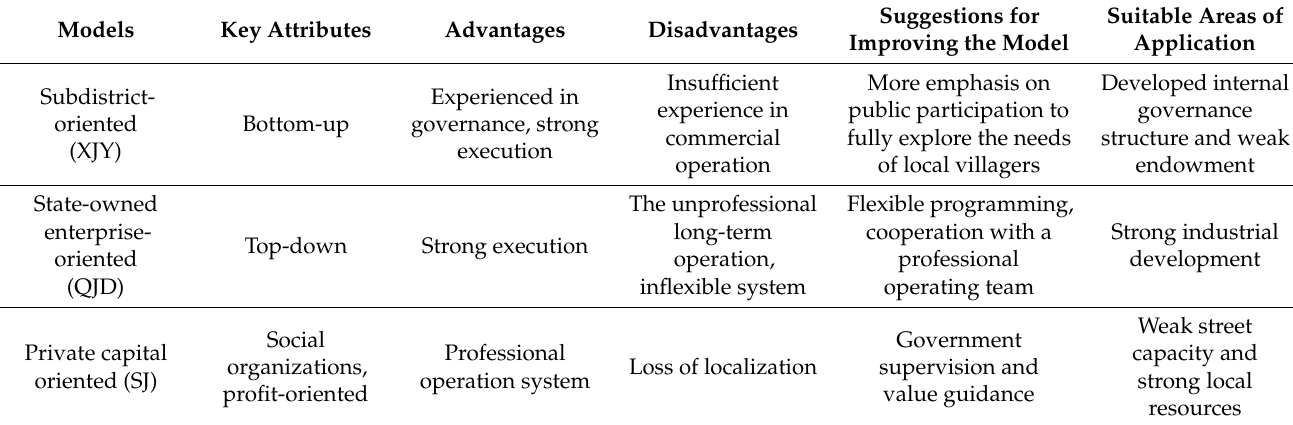
Table 3. Comparison of stakeholder-led approaches of three metropolitan